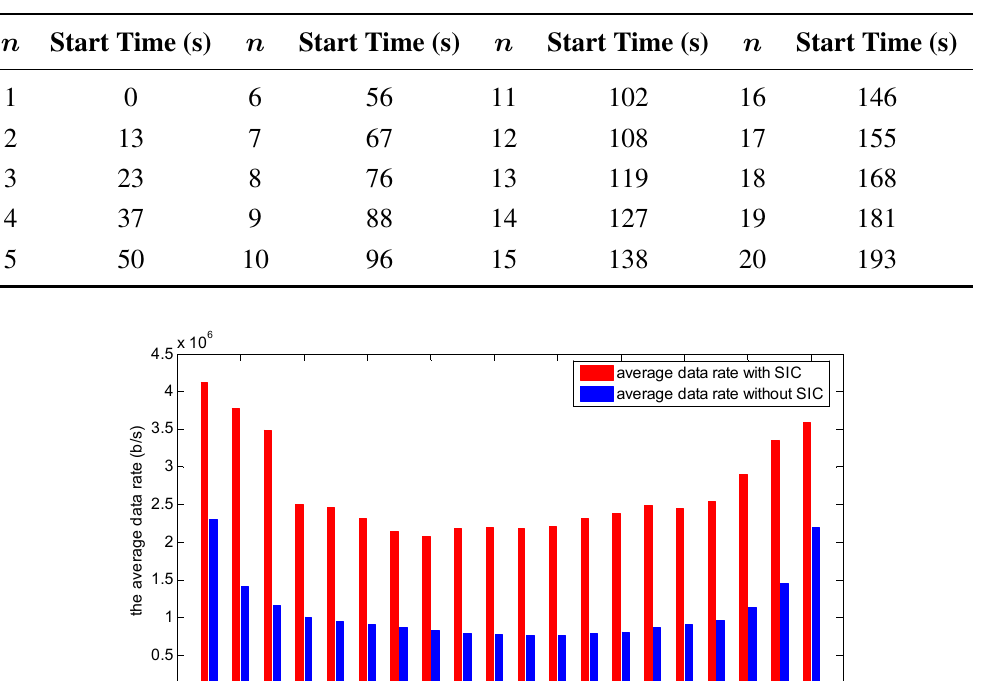
Table 1. Start times of the 20 locomotives.